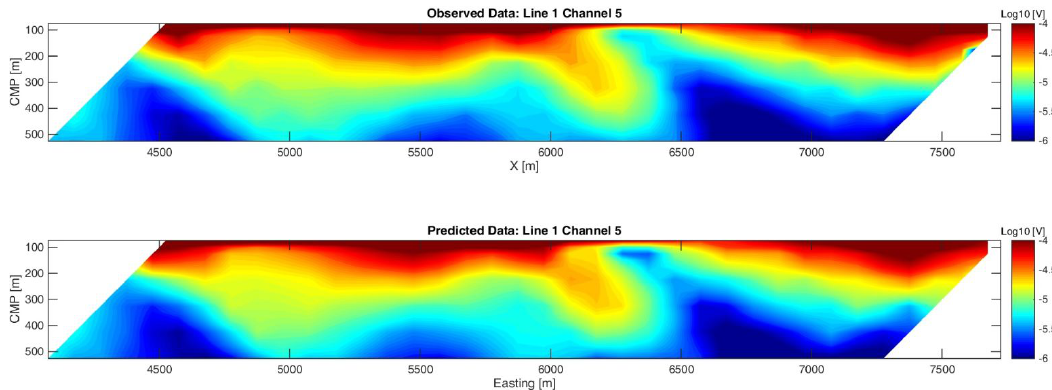
Figure 7. IP survey lines (Pseudo sections of the observed (top) and predicted (bottom) pole–dipole IP data; Line 1, time channel